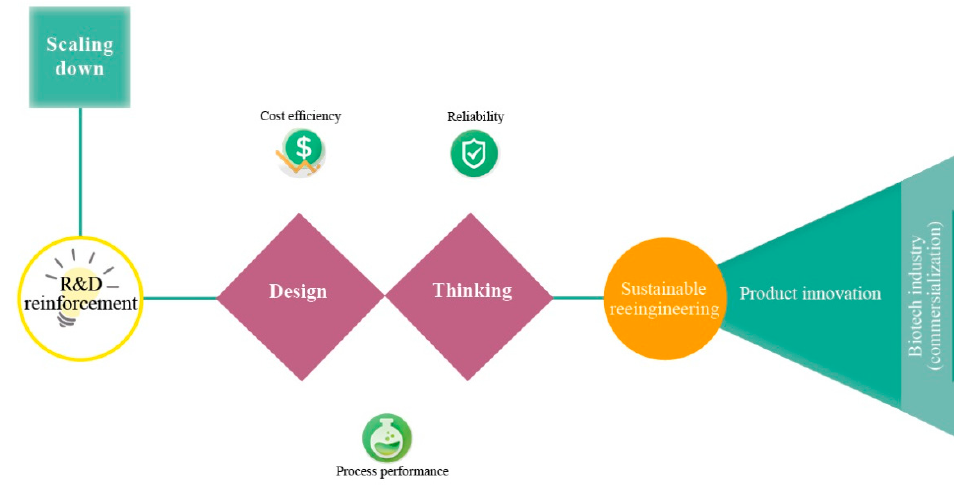
Figure 2. Engineering pathways of the miniaturization concept (top left to right).